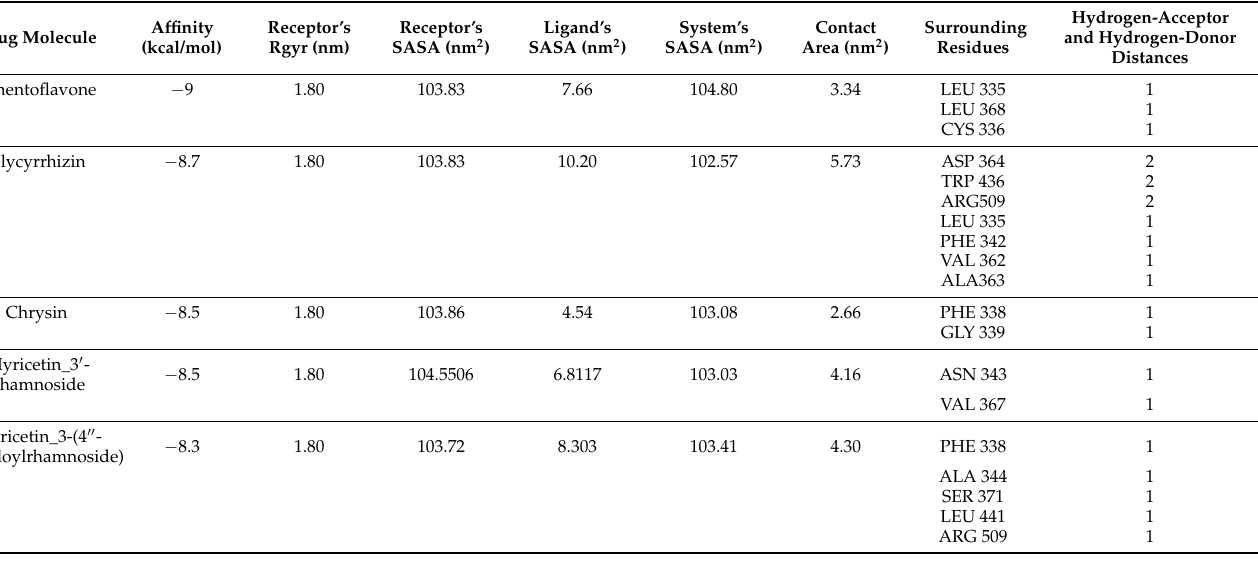
Table 3. Molecular docking scores and related